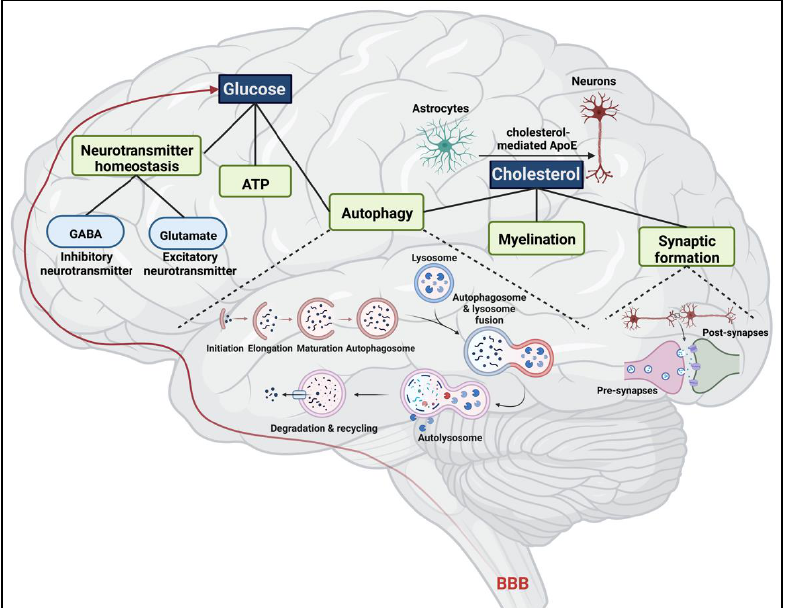
Figure 3. Key roles of glucose and cholesterol in the brain. Glucose enters the brain through the blood-brain barrier (BBB) and is subsequently involved in ATP production, neurotransmitter homeostasis and autophagy activity. In the adult brain, cholesterol is mainly synthesized in the astrocytes and then delivered to neurons by transporter “ApoE”. In the brain, cholesterol greatly contributes to myelination, synaptic formation, and regulates autophagy. ApoE: apolipoprotein B; ATP: adenosine triphosphate; BBB: blood-brain barrier. GABA: gamma amino butyric acid. Information obtained from [119,121 – 132]. Figure is created with BioRender.com.